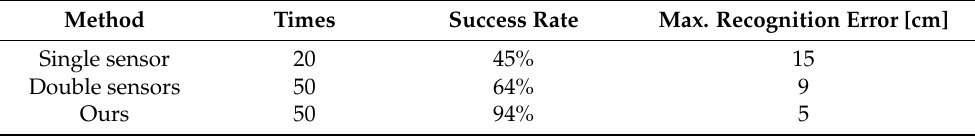
Figure 19. Parking space matching and trajectory generation. The longitudinal and horizontal distance between the vehicle and the parking space can affect the trajectory generation. If the size of parking spaces is fixed, the length and width of the parking space can be determined. Therefore, only the coordinates of the red point (reference point) in Figure 18 should be confirmed. The longitudinal and horizontal distance between the vehicle and the parking space can then be calculated based on the confirmed reference point. We measure the reference point 10 times and compare errors between the actual coordinates and measured results as shown in Table 5. It can be viewed that the errors on x and y directions are within 4 cm and 5 cm, respectively, which satisfy the parking requirement.